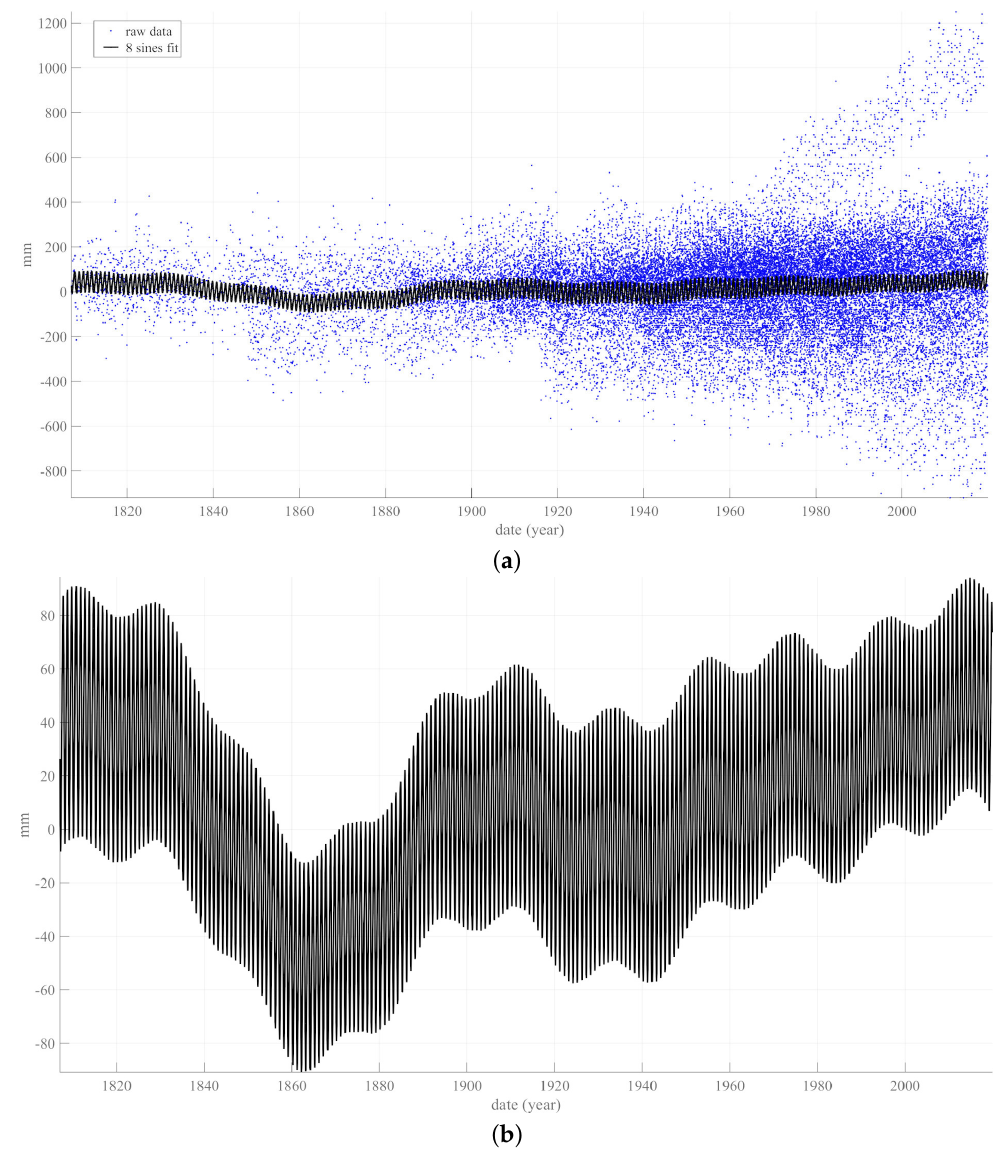
Figure 4. Fit of the 31 tide gauges. ( a ) Data points from the 31 tide gauges used in building GSLTG and their sinusoidal fit, with 8 sine waves. ( b ) The fit (black curve) of ( a ) with an enlarged ordinate